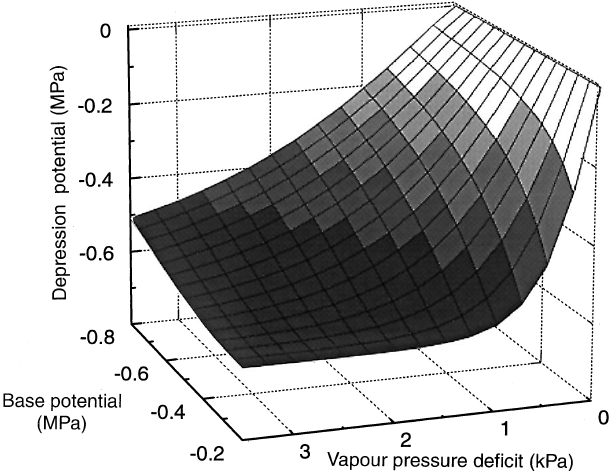
Fig. 3. Variation in depression potential (cid:133) (cid:87) d (cid:134) depending on the base water potential (cid:133) (cid:87) b (cid:134) and vapour pressure deficit of the atmosphere (VPD). The means for the intervals of (cid:87) d indicated by consecutive tones from white to dark grey : (cid:255) 0 : 11 ; (cid:255) 0 : 21 ; (cid:255) 0 : 31 ; (cid:255) 0 : 41, and (cid:255) 0 : 51 MPa